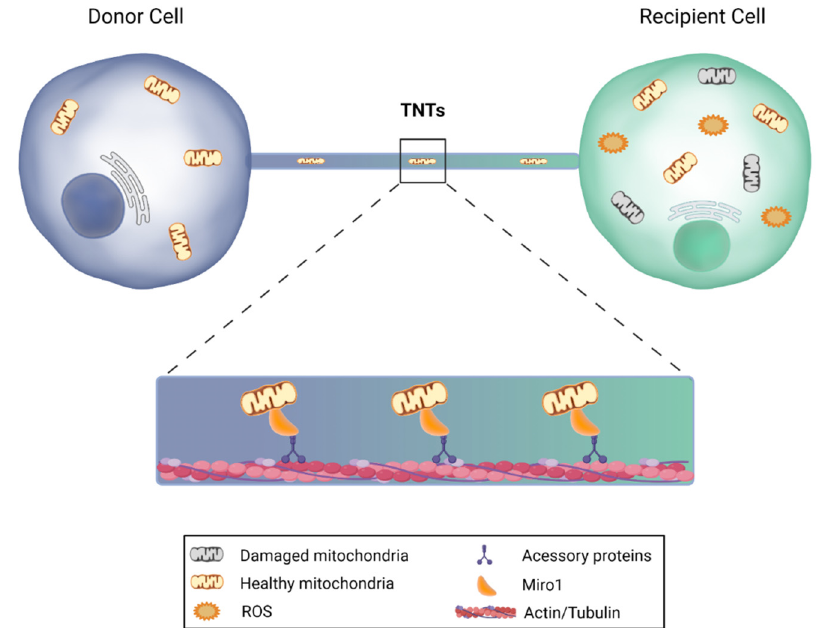
Figure 4. Mitochondrial transfer via tunneling nanotubes. Under certain circumstances, cells are capable of sending mitochondria to recipient cells through nanotubular actin-based structures. The donor cell extends a filopodia-like protrusion toward the recipient cell, forming a strait connected bridge between cells, in which the transfer is feasible in both directions. Miro1, a protein that is anchored to the outer mitochondrial membrane, binds to the motor proteins kinesin and dynein, and promotes mitochondrial transfer, leading to the restoration of aerobic respiration and improvement of target cell survival. This image was created with BioRender.com.